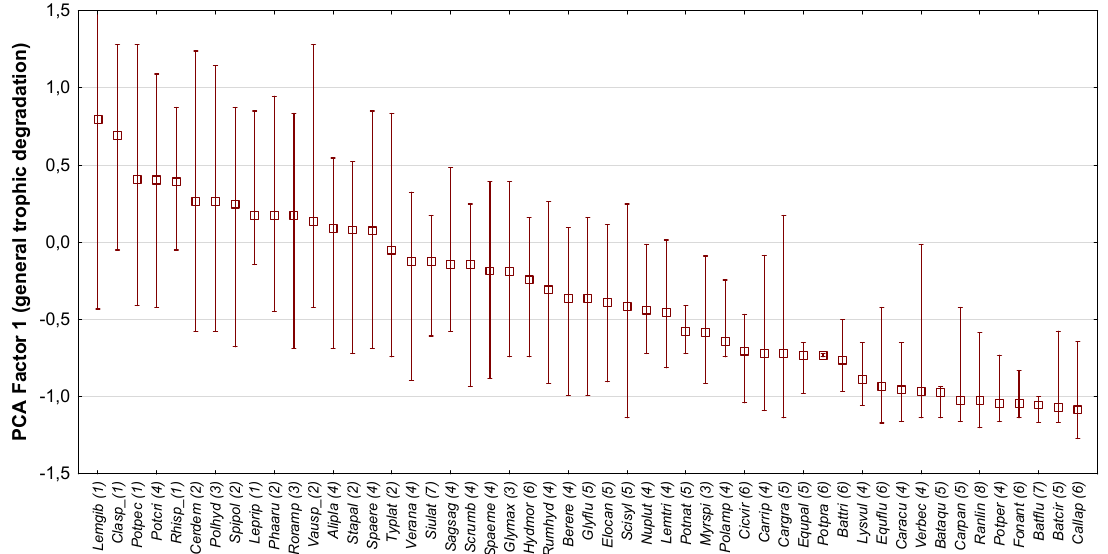
Figure 3. Macrophyte taxa in descending order according to median of PCA Factor 1 (range of quartiles marked). Abbreviations of the macrophytes are explained in Table S2. MIR indicator values ( l ) are shown in brackets. Table 6. Spearman’s rank correlation between indicator values of di ff erent macrophyte metrics (MIR, IBMR, MTR, RMNI, and ITEM) and environmental factors (median of total phosphorus concentration and general trophic degradation gradient—PCA Factor 1) for 51 indicative macrophytes detected at a minimum of four river sites. Significant correlations at p < 0.05 are marked in red.